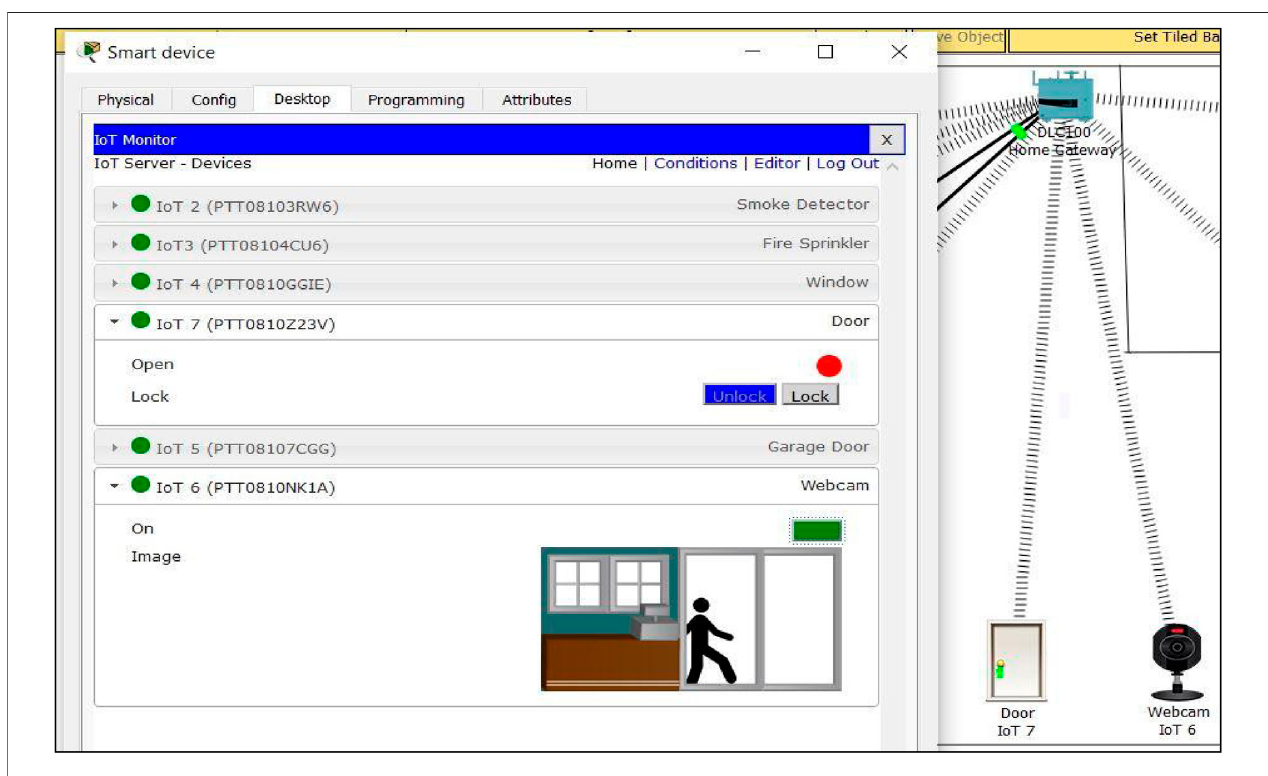
FIGURE 3 | Functioning of locking and unlocking of main door via security camera.